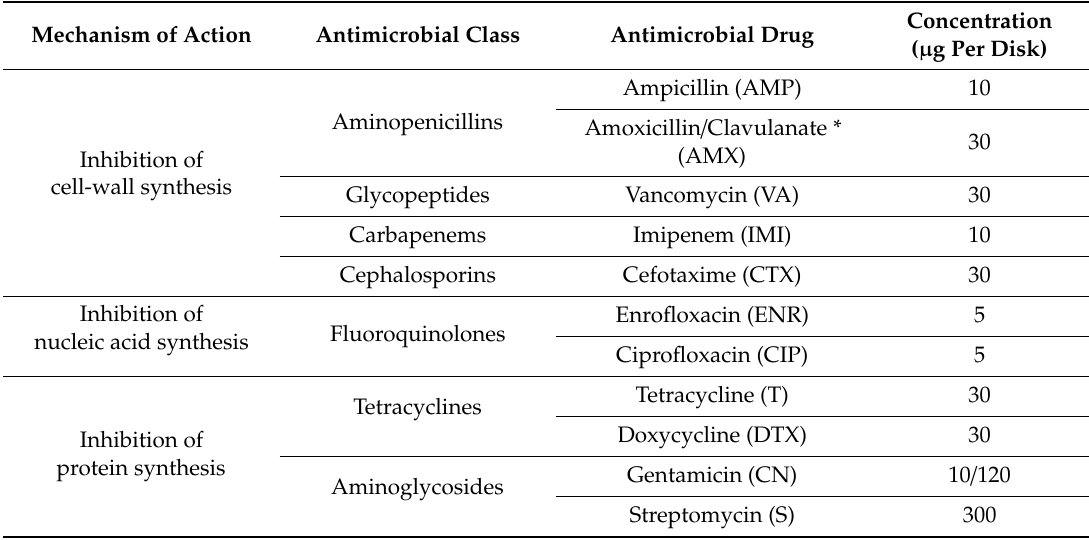
Table 4. Antimicrobial agents used in the antimicrobial susceptibility test, grouped by mechanism of action, class and concentration